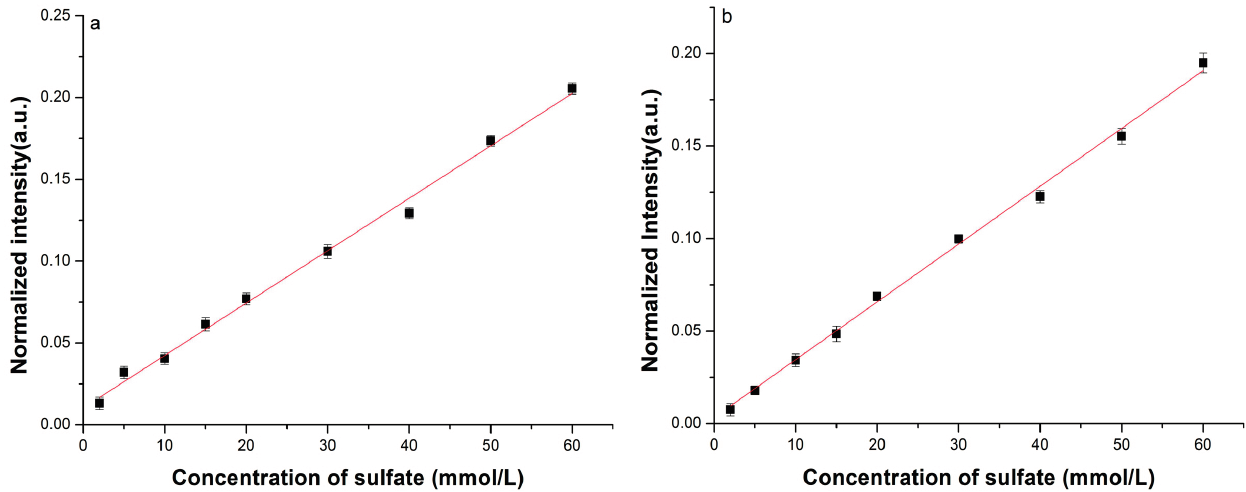
Figure 7. The calibration curve of sulfate concentration with ( a ) conventional Raman spectroscopy and ( b ) LCOF-Raman